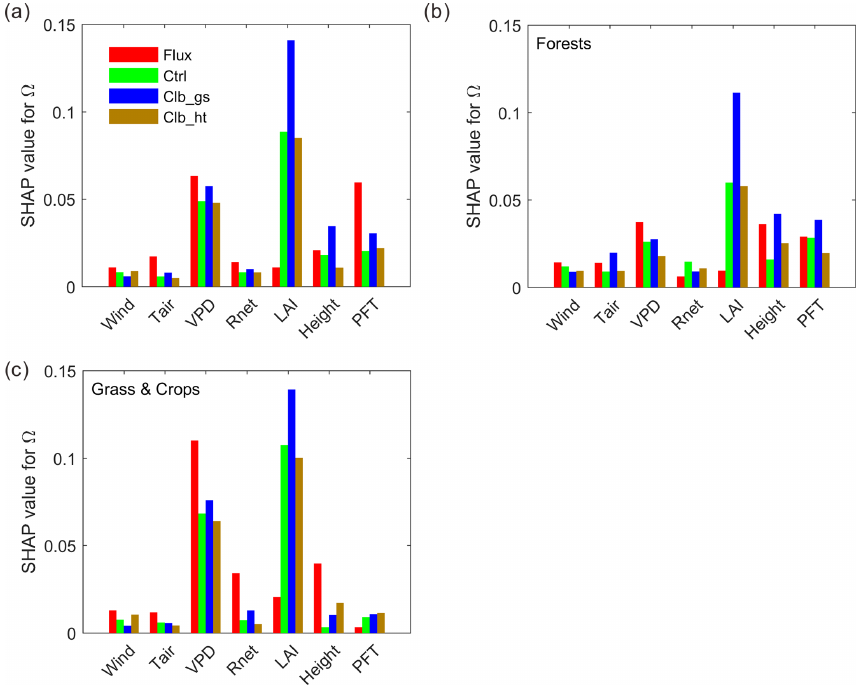
Figure 4. Importance of different factors based on absolute SHAP values of (cid:127) (the expectance of factor-induced deviation of (cid:127) from the averages of all samples). (a) Random forest model built by data from all PFTs. (b) Model using only forest data. (c) Model using only grassland and cropland